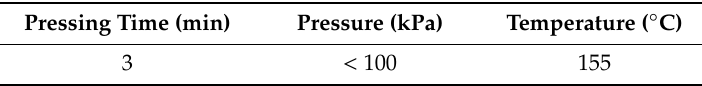
Table 3. Manufacturing conditions